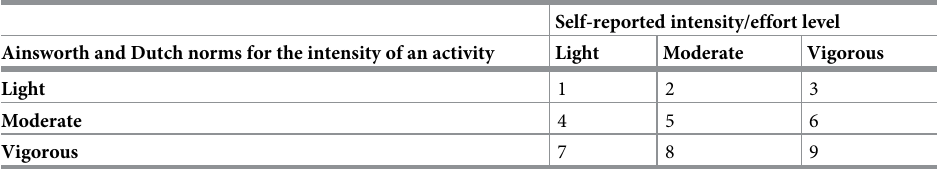
Table 2. Intensity scores assigned to various levels of activity and self-reportred